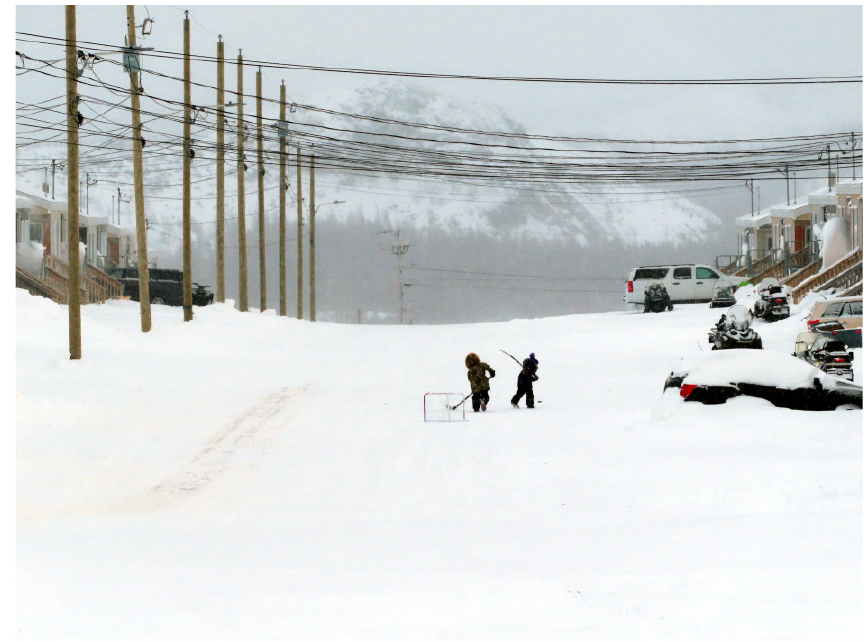
Figure 2. Young Kangiqsualujjuamiut playing under powerlines, a sign of a now sedentary